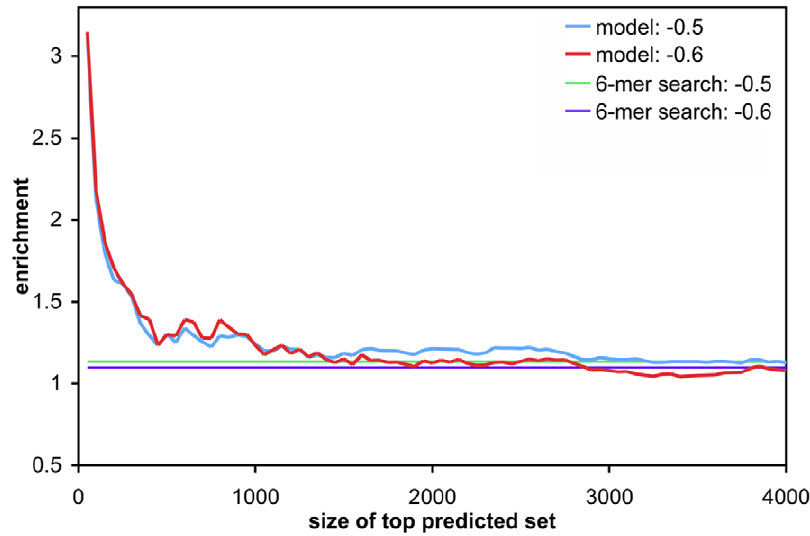
Figure 6. Enrichment of highly down-regulated mRNAs for miR-K12-11 target predictions. As in Figure 4, the enrichment of bona fide targets within gene sets of increasing size, ordered by increasing model score, is shown. A 6-in-8 filter was used for model training and prediction (cf. Figure 4B). Different observed mRNA log 2 fold change values ( 2 0.5, and 2 0.6) were used as a cutoff for bona fide targets. The corresponding baseline enrichments resulting from 6-mer seed matches are also shown.